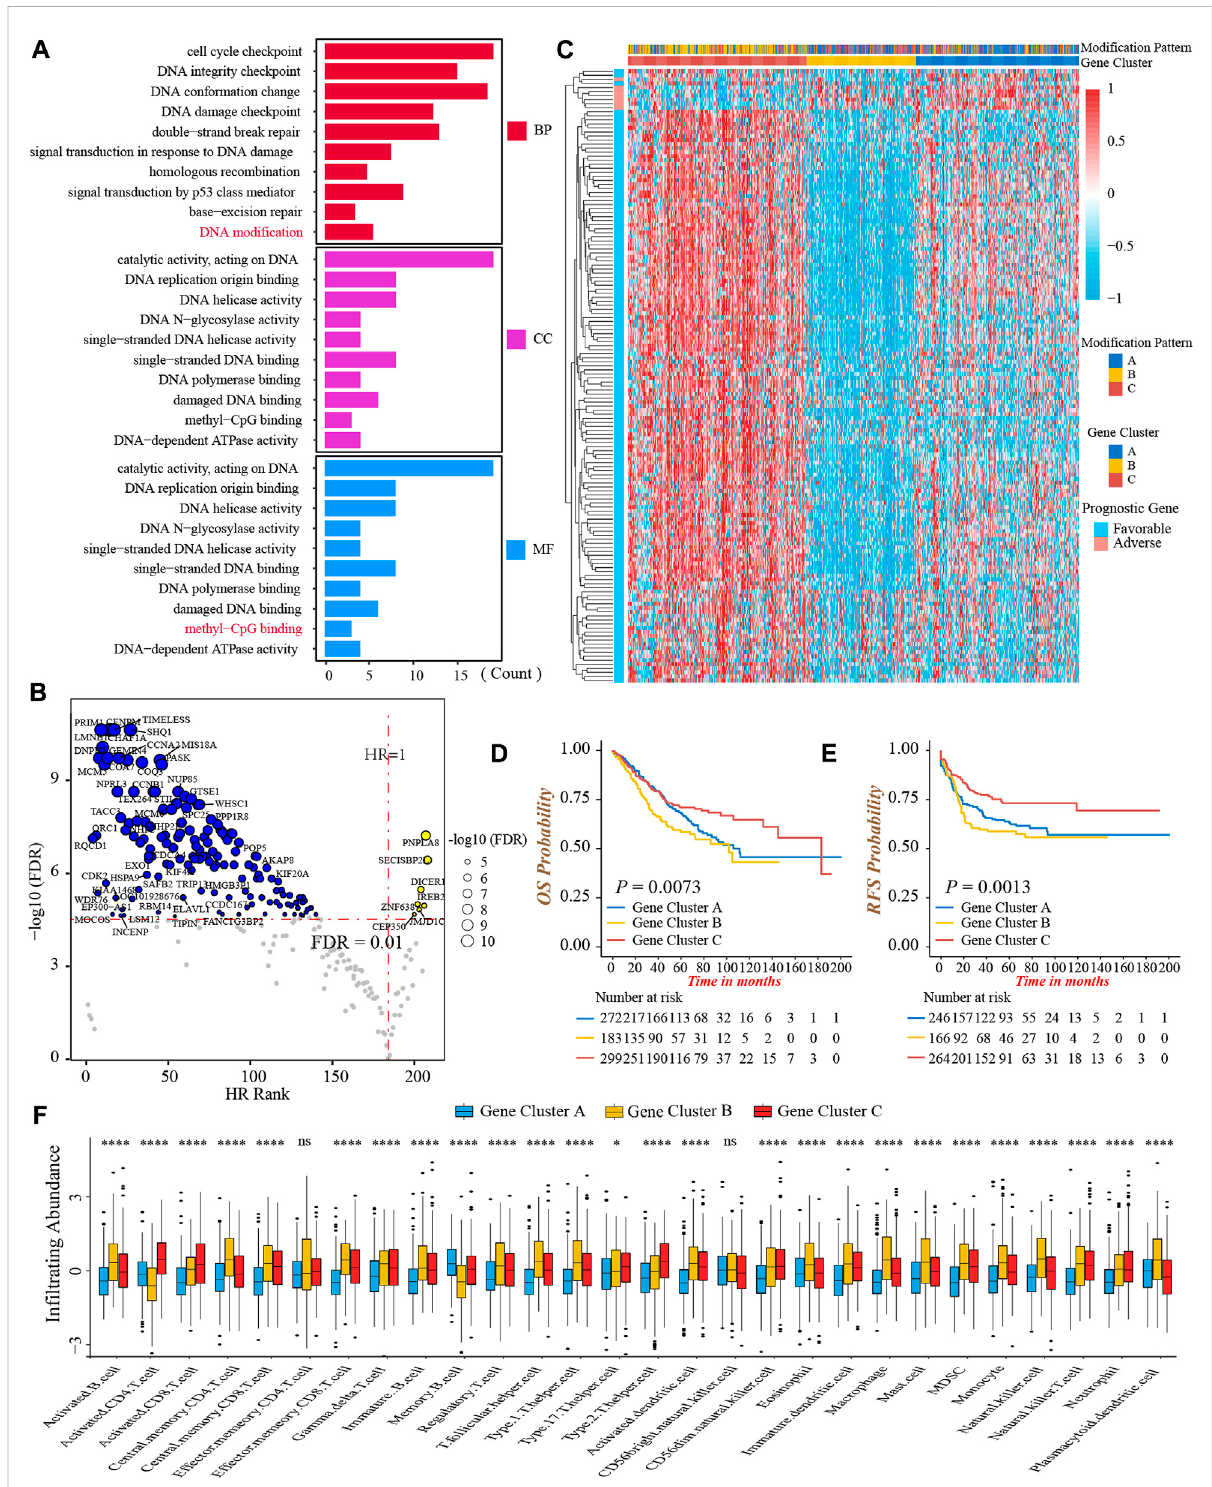
Generation of DNA methylation gene signature. (A) Functional annotation of 249 DEGs among three DNA methylation modi fi cation patterns using GO enrichment analysis. BP, biological process; CC, cellular component; MF, molecular function. (B) Volcano Plot presented the DEGs signi fi cantly associated with prognosis. (C) The heatmap of 152 prognostic DEGs ’ expressions among three DNA methylation gene clusters-A, -B, and -C. (D) Overall survival analysis for the three DNA methylation gene clusters (Log-rank test, p = 0.0073). (E) Recurrence-free survival analysisforthethreeDNAmethylationgeneclusters(Log-ranktest, p =0.0013). (F) Thein fi ltratingabundanceof28TMEcelltypesamongthreeDNA methylation gene clusters (Kruskal-Wallis test; ns, no signi fi cance; * p < 0.05; ** p < 0.01; *** p < 0.001; **** p <